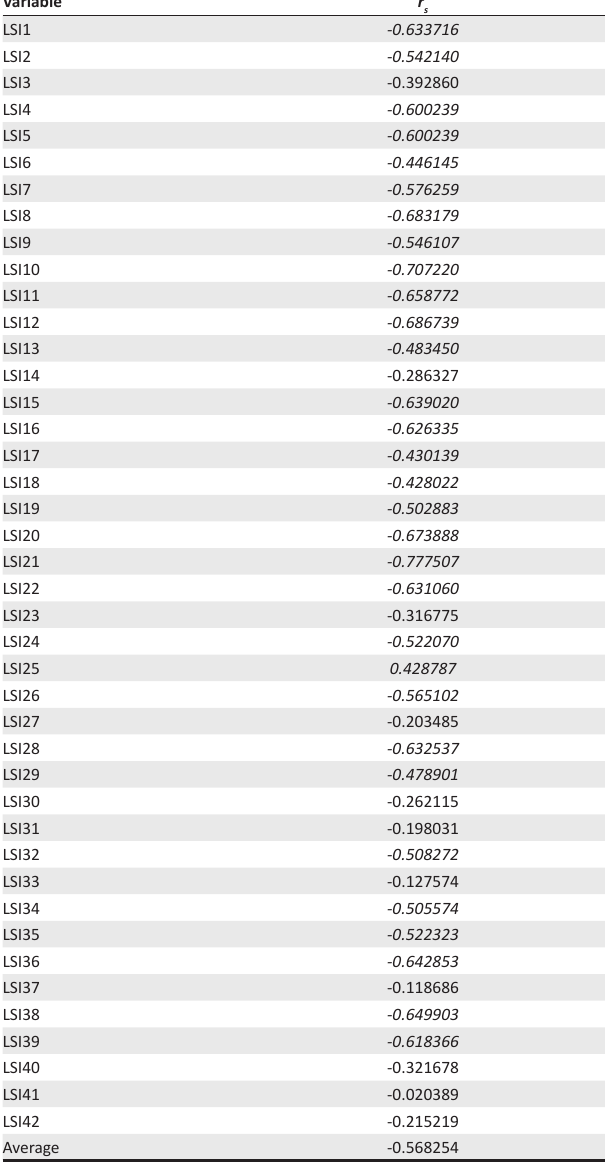
TABLE 6: Spearman’s rho values per LSI question for Pool